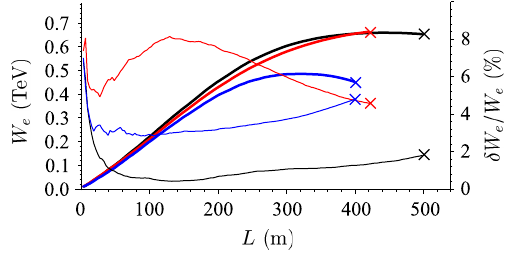
FIG. 13. (Color) Effect of the witness length: witness energy (thick lines) and energy spread (thin lines) versus traveled distance for witness lengths 0.16 mm (blue), 0.24 mm (black), and 0.35 mm (red).